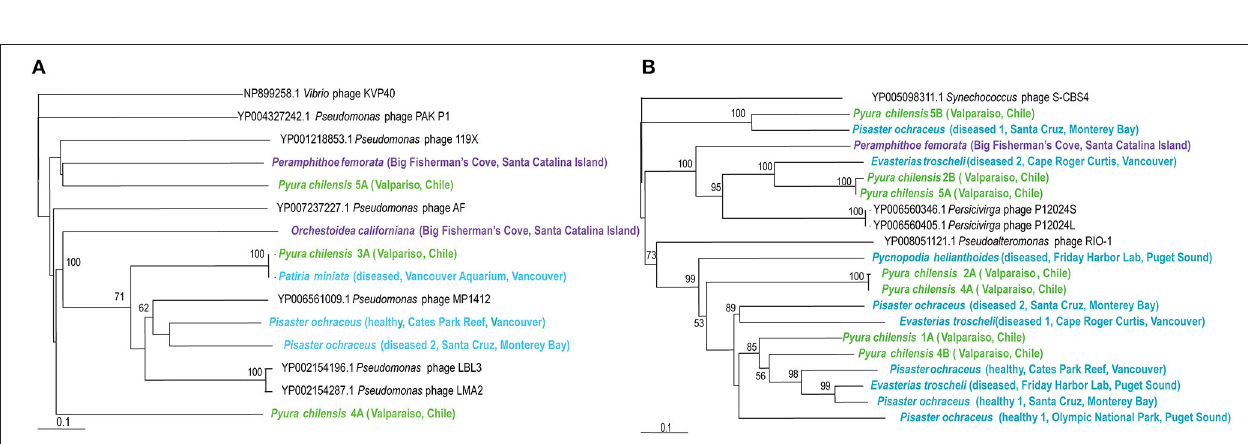
FIGURE 5 | (A, Left panel) Phylogenetic representation based on a 146 aa alignment of Persicivirga phage portal protein, including closest relatives based on BLASTX comparison against the non-redundant database at the NCBI. (B, Right panel) Phylogenetic representation based on a 156 aa alignment of Pseudomonas phage helicase protein, including closest relatives based on BLASTX comparison against the non-redundant database at the NCBI. The alignment was performed with CLUSTAL W and the tree drawn using neighbor joining. Bootstrap values of 1000 tree iterations that are > 50% are indicated at branch nodes. Scale bar represents 0.1 substitutions per site. The phyla are color-coded: blue are echinoderms, green are urochordates and purple are